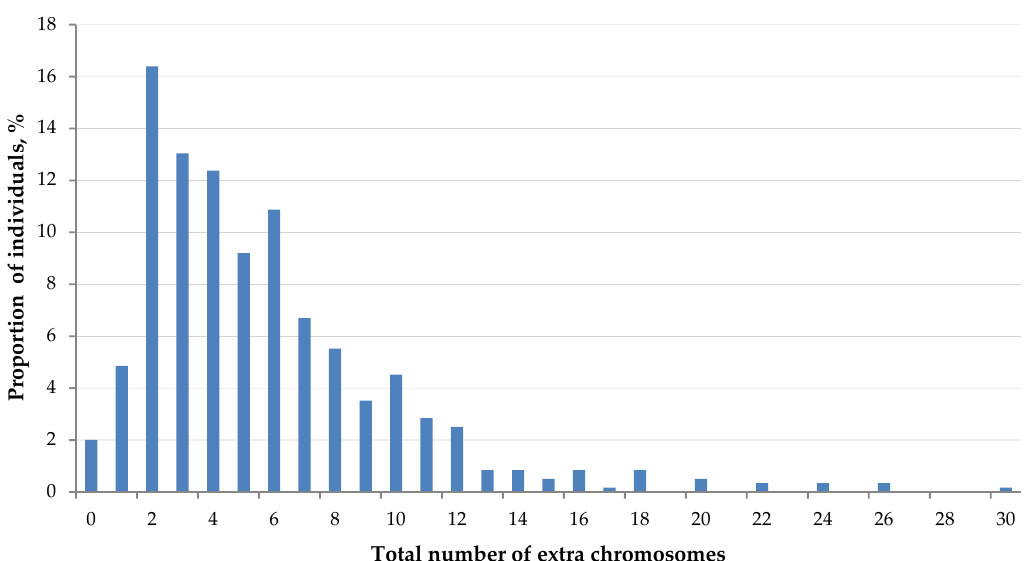
8 of 12 Table 4. Correlation between the number and frequency of B chromosomes in karyotypes of A. peninsulae (Spearman’s rank test, p < 0.05). Type of B Chromosome Large Metacentric